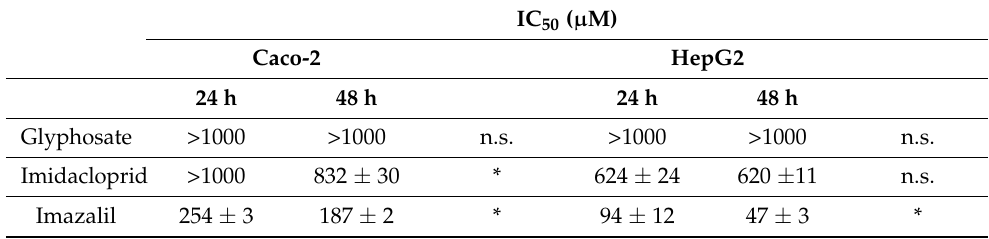
Table 1. IC 50 values of pesticide-induced cytotoxicity in Caco-2 and HepG2 cells.